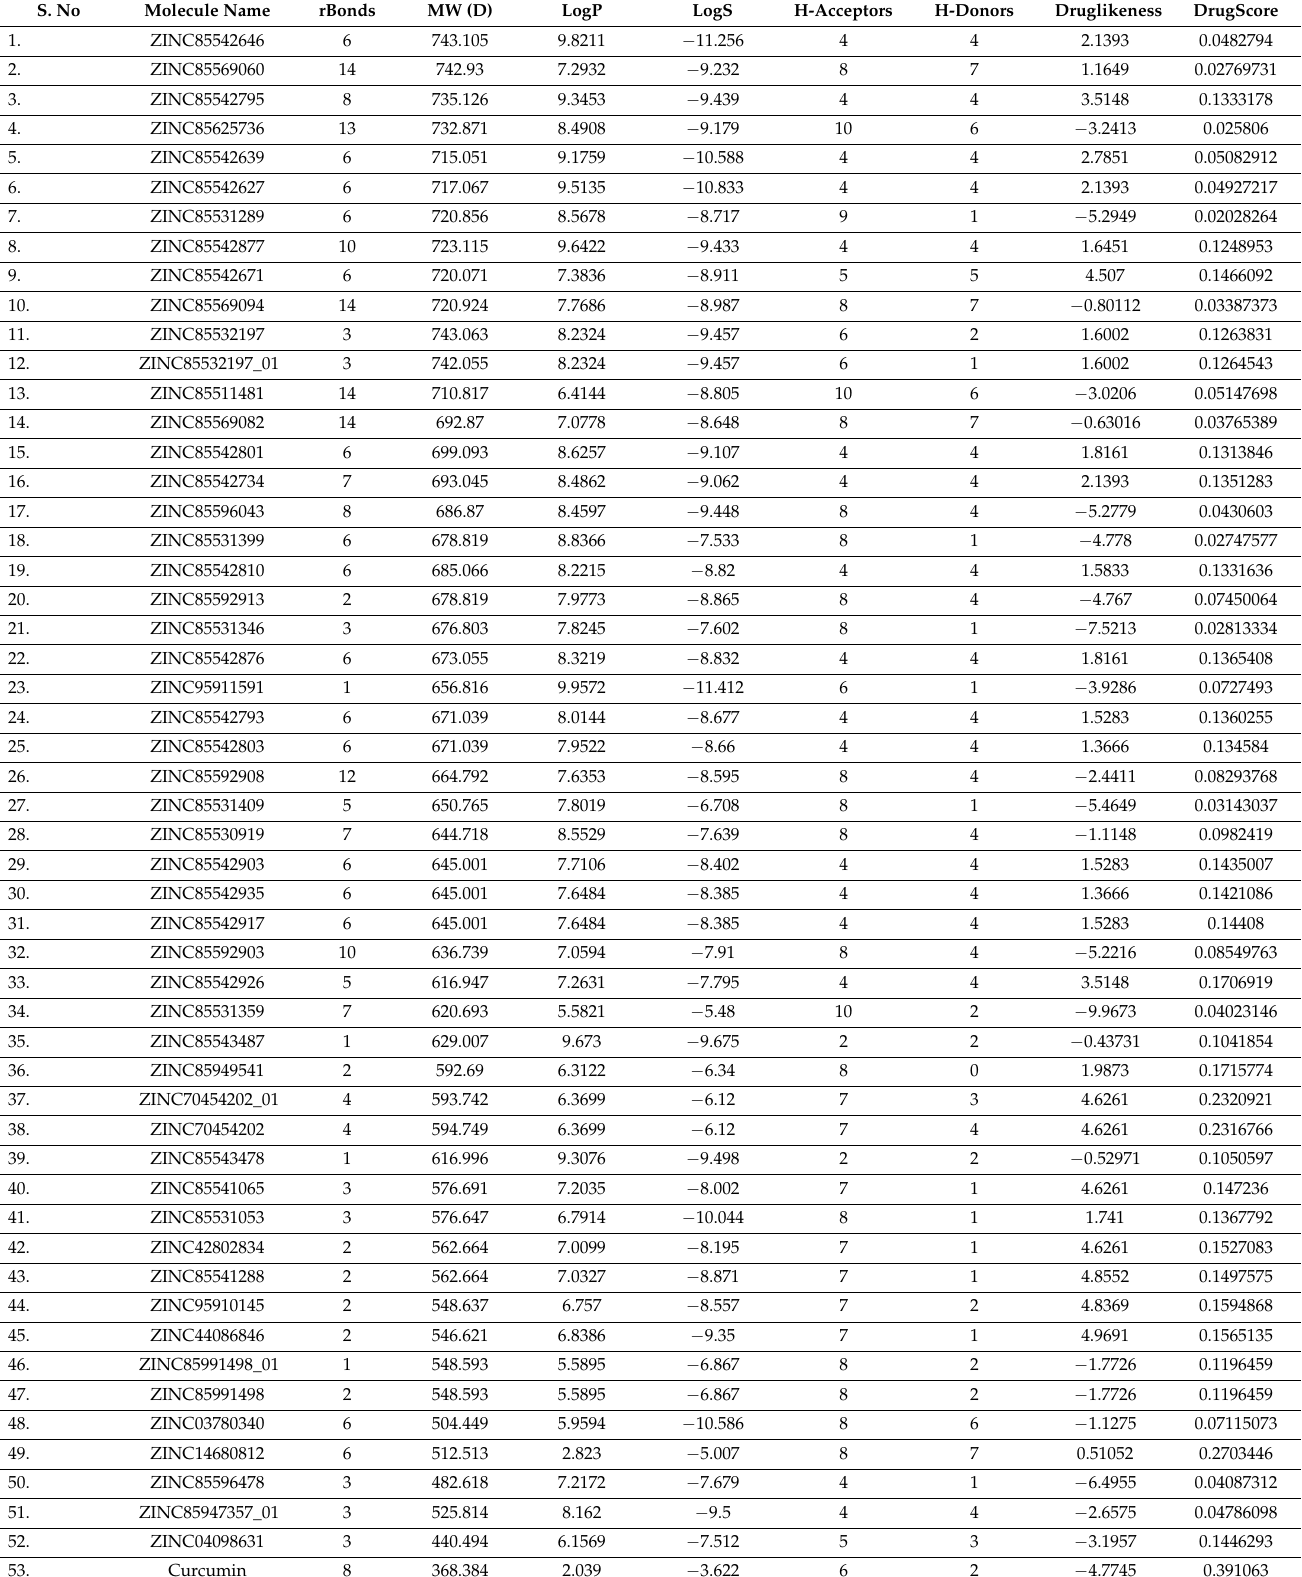
Table 1. Physicochemical properties of the selected